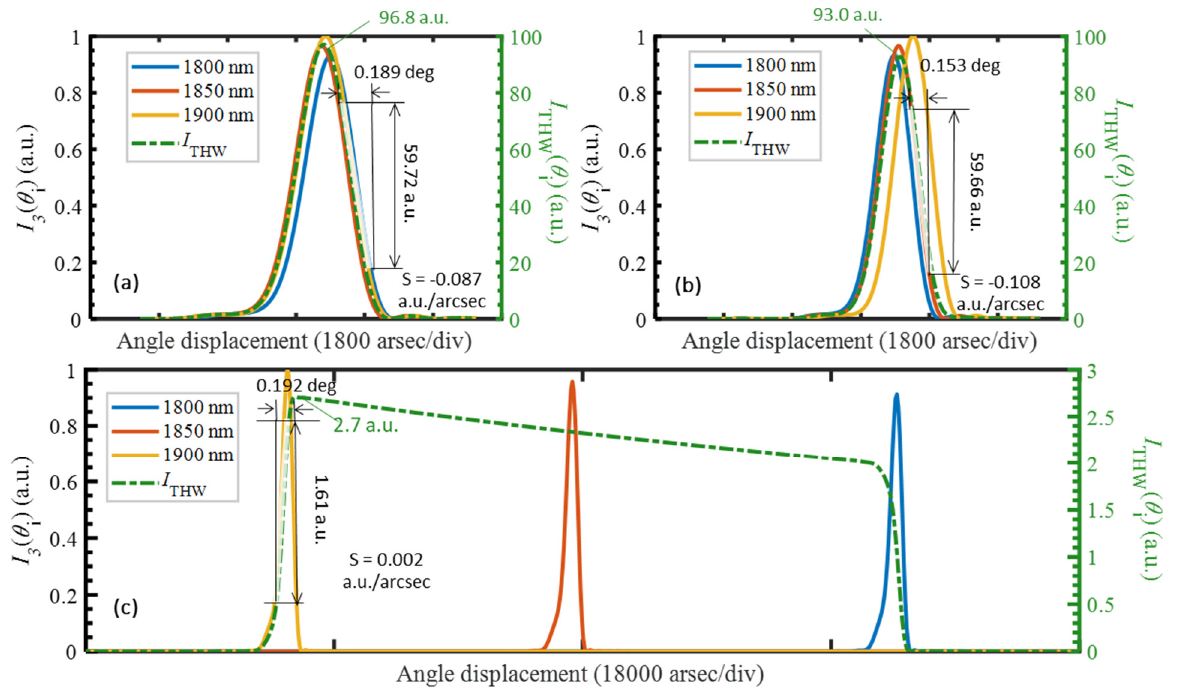
Figure 7. The calculated angle dependence of I 3 ( θ i ) and I THW ( θ i ) of ( a ) α -BBO, ( b ) Calcite, and ( c ) Rutile.